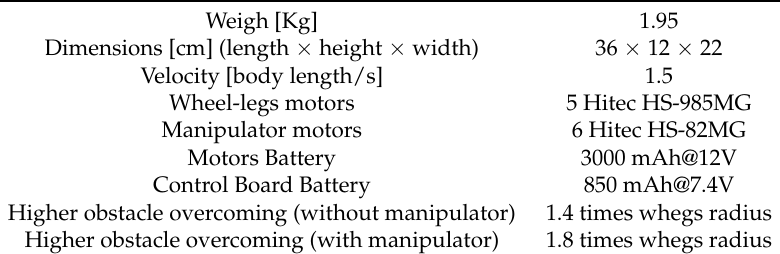
Table 2. Technical characteristics of the